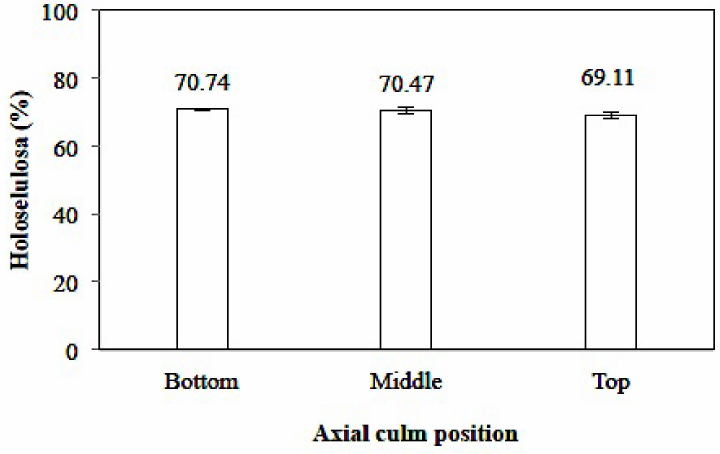
Figure 8. Holocellulose content of Gigantochloa pruriens